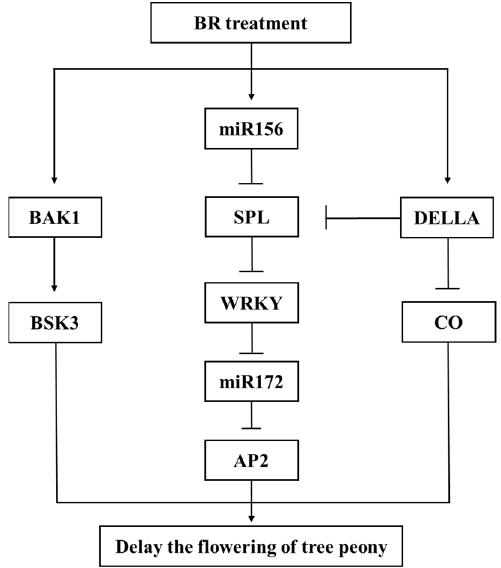
Figure 9. Putative gene molecular pathway of flowering in tree peony. The lines indicate correlation. The arrows indicate facilitation. Bars indicate inhibition.